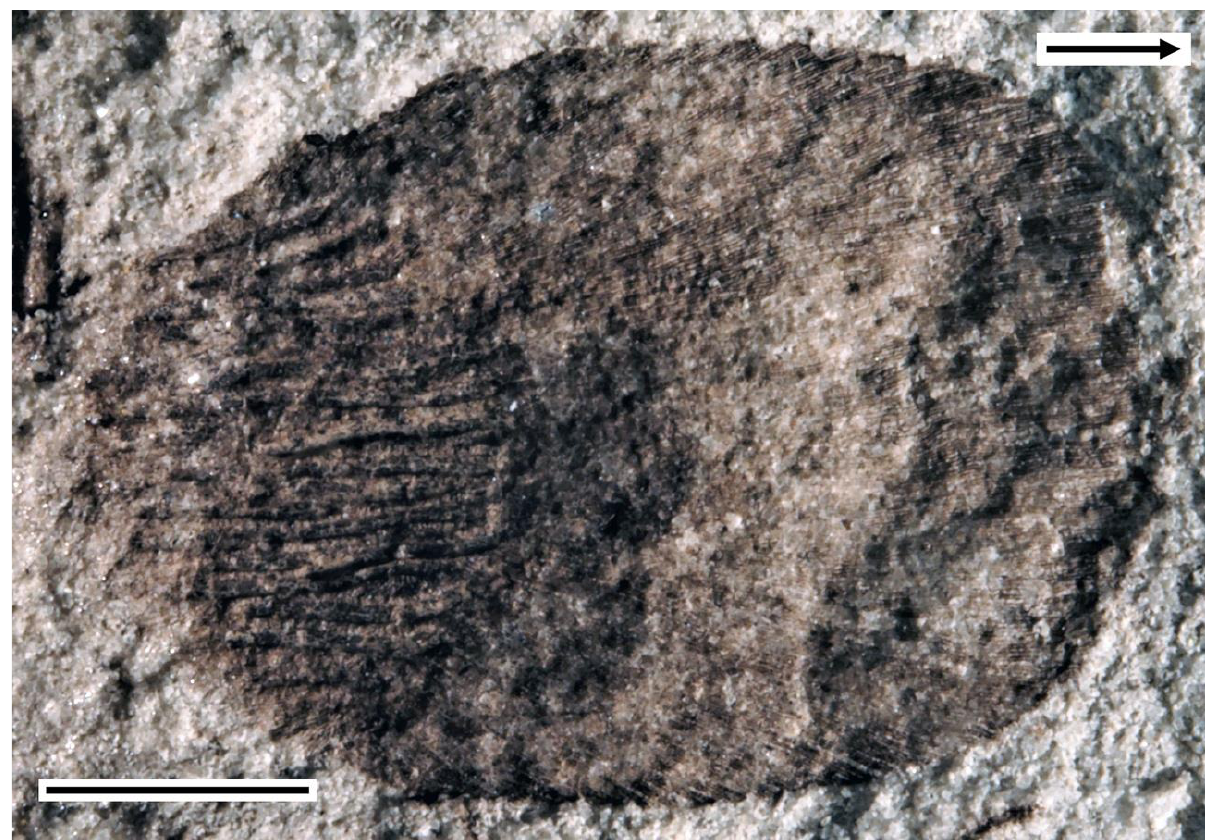
Figure 6. Actinistian scale, specimen MLU Sei.2010.78 from horizon MFL at Fuchsberg Quarry near Seinstedt, Lower Saxony, upper Norian, Upper Triassic. Arrow points anteriad. Scale bar = 3 mm. Photograph, courtesy of John Chorn.